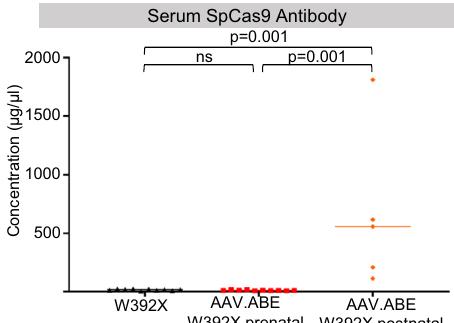
Fig. 8 Postnatal base editing in Idua-W392X mice is associated with anti- SpCas9 speci fi c antibodies. Ten-week-old Idua- W392X mice were intravascularly injected with AAV.ABE.Idua. Serum from Idua- W392X mice prenatally ( N = 10) or postnatally ( N = 5) treated with AAV.ABE.Idua was harvested 1-month post injection and assessed for anti-SpCas9 antibodies. W392X = uninjected control serum ( N = 10). Two-tailed Wilcoxon test for multiple comparisons was used with α = 0.05. AAV.ABE indicates